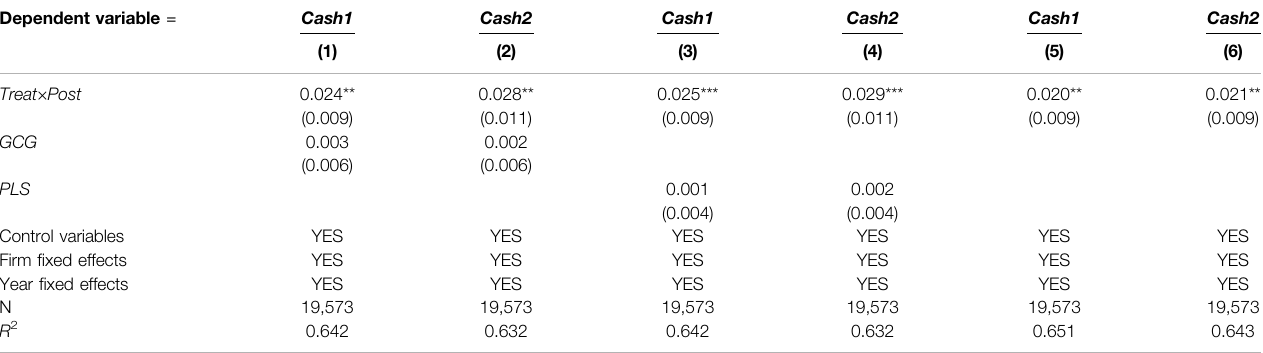
TABLE 5 | Controlling for other policy